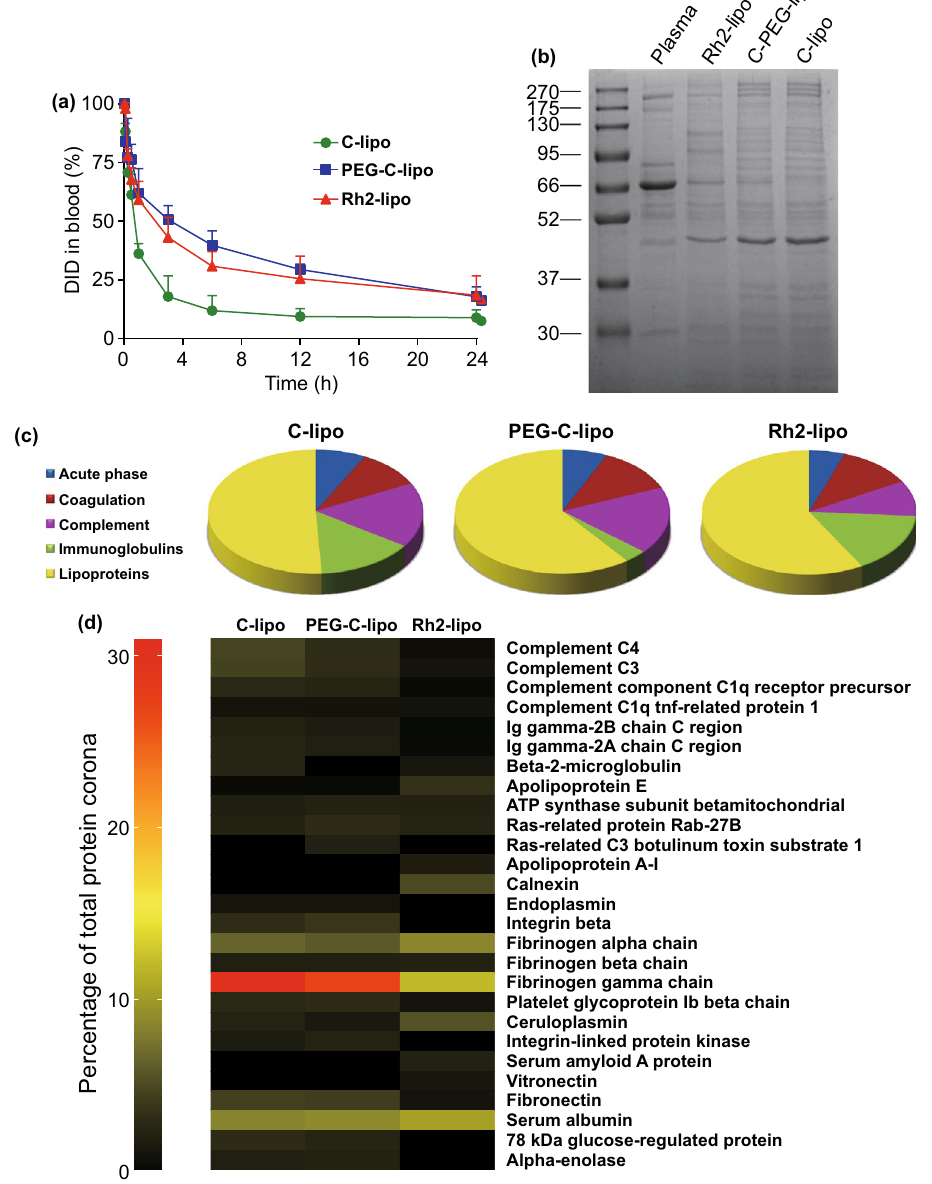
Fig. 3 Rh2 worked as a long-circulating stealther, which specifically prolonged circulation behavior of liposomes. a Blood circulation profiles of C-lipo, PEG-C-lipo and Rh2-lipo ( n = 3; mean ± SD). b Representative SDS-PAGE gel of protein coronas obtained from three liposomes fol- lowing 1-h incubation with plasma. c Classification of protein corona components according to their function in biological processes and the protein number of each type ( n = 2). d Heat map of the most abundant proteins in the protein corona. Only those proteins that constitute at least 1% of the protein corona on one of the liposomes are